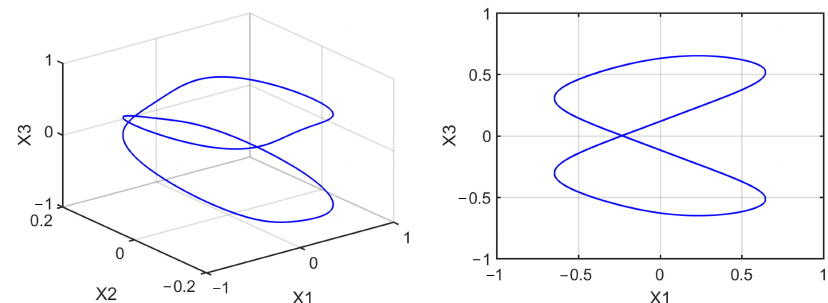
Figure A11. Periodic-2 motion of σ 1 = 2.9801.